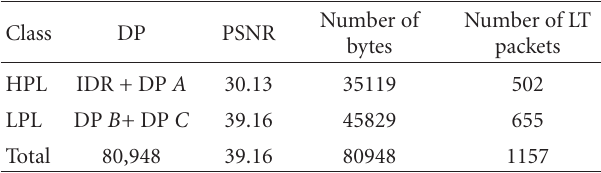
Table 1: Partition sizes for the first GOP of “Paris” and “Football” sequences.